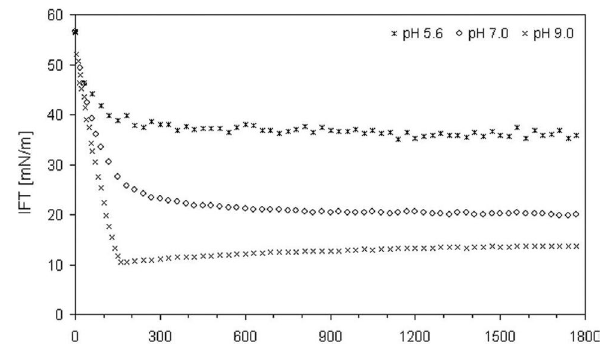
Fig. 5 Effect of pH on interfacial tension of biphasic system contain- ing tetraacid (Brandal et al. 2006)